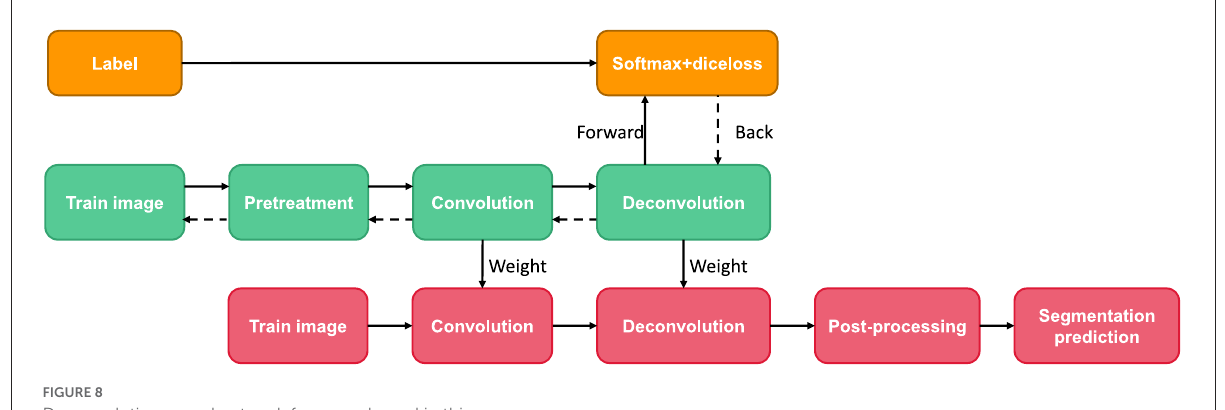
FIGURE8 Deconvolution neural network framework used in this paper.